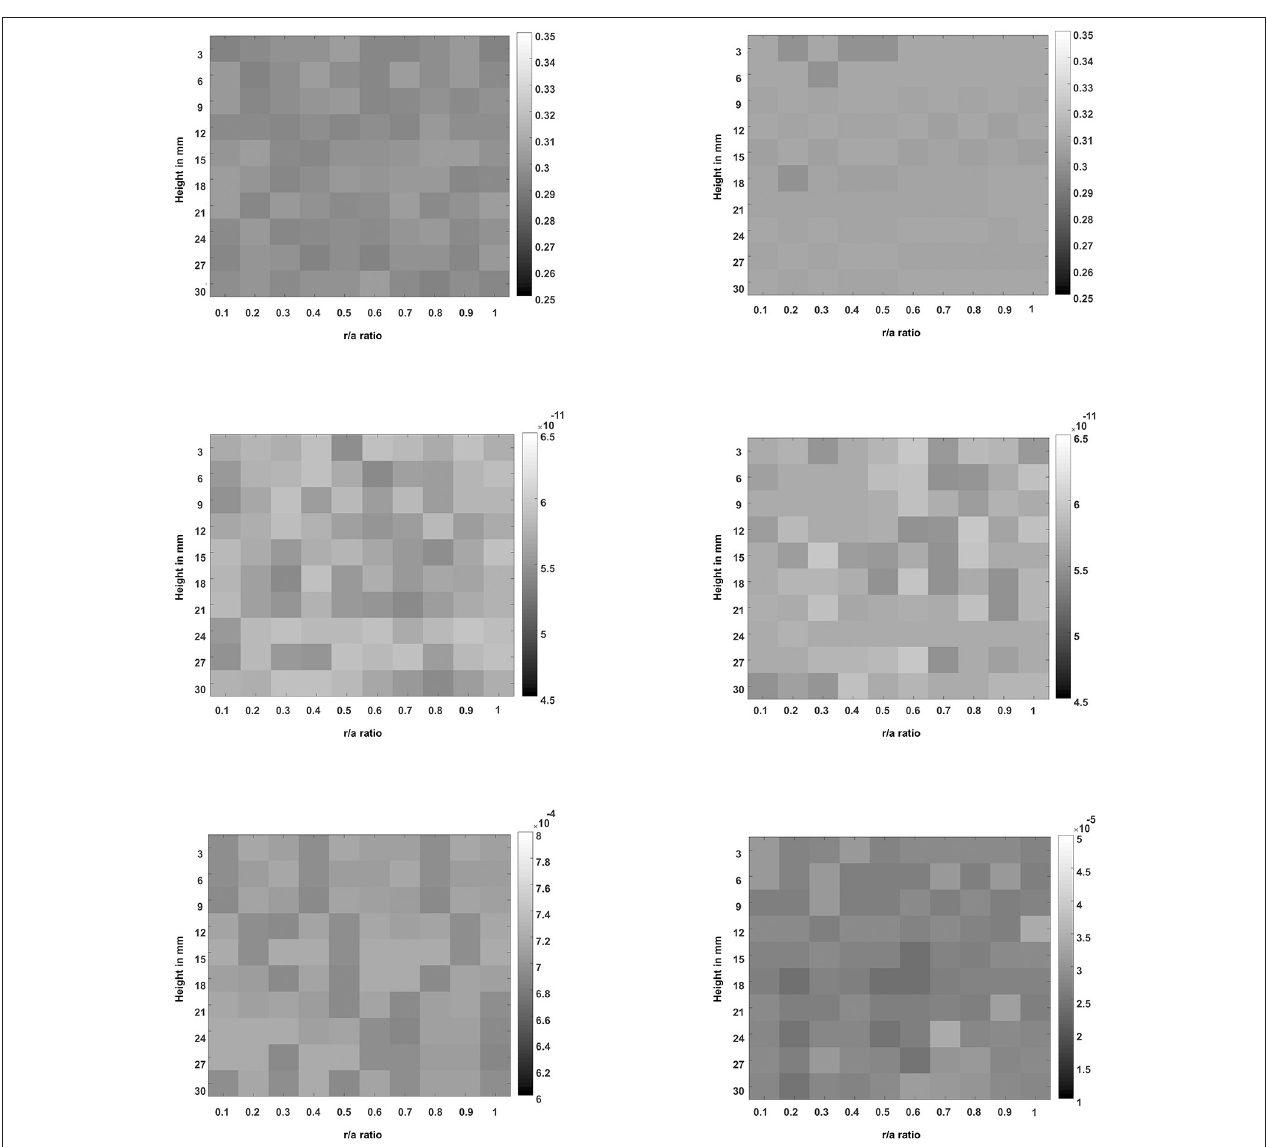
FIGURE 10 | The images of the poroelastic model parameters such as the Poisson’s ratio (top row) and the product of aggregate modulus and permeability (middle row), and the images of the cost function values per pixel (bottom row). The left column shows the images that were recovered from a simulated poroelastic phantom subjected to a strain relaxation compression (an applied force of − 8N), and the right column shows the images that were recovered from a simulated poroelastic phantom subjected to a stress relaxation compression (applied strain of − 3%). The grayscale bars were arbitrarily scaled to allow comparisons, with maxima and minima chosen to include the maximum and minimum pixel values within each